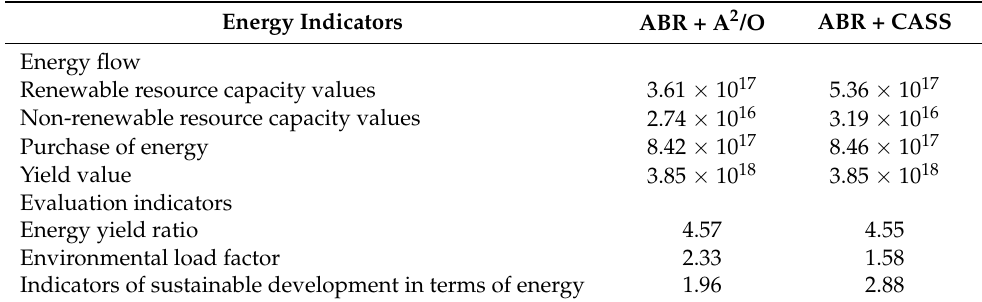
Table 3. Main emergy indicators for the 2